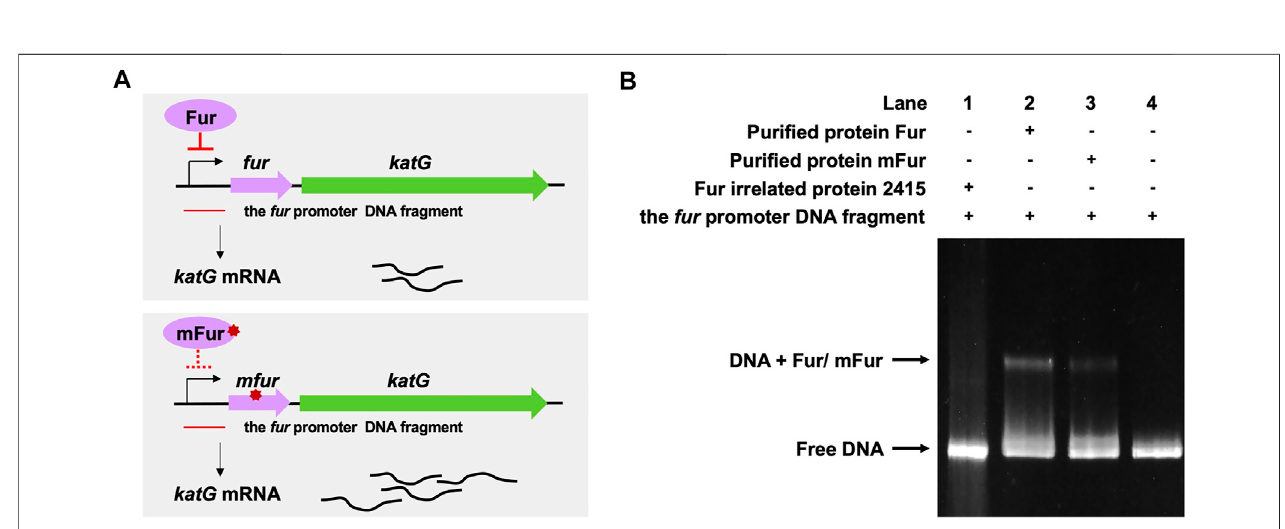
FIGURE 4 | A28V Fur mutant protein decreased DNA binding to the fur promoter. (A) Genetic organization of the fur - katG and the schematic diagram of Fur negativeregulationof katG (upperpanel).Geneticorganizationofthe mfur - katG andtheschematicdiagramofmFurresultedinderepressionof katG withincreasing katG mRNA(bottompanel).Theredlineindicatesthe fur promoterDNAfragment. (B) Electrophoreticmobilityshiftassays(EMSAs)ofthebindingofFur/mFurproteintothe fur promoterDNAfragment.Puri fi edMSMEG_2415protein(2415),irrelatedtoFur,expressedin E.coli ,wasruninthe fi rstlaneofa4 – 20%polyacrylamidegel.Gelshift caused by Fur (lane 2) and mFur (lane 3) is shown. The image shown is representative of at least three experiments.